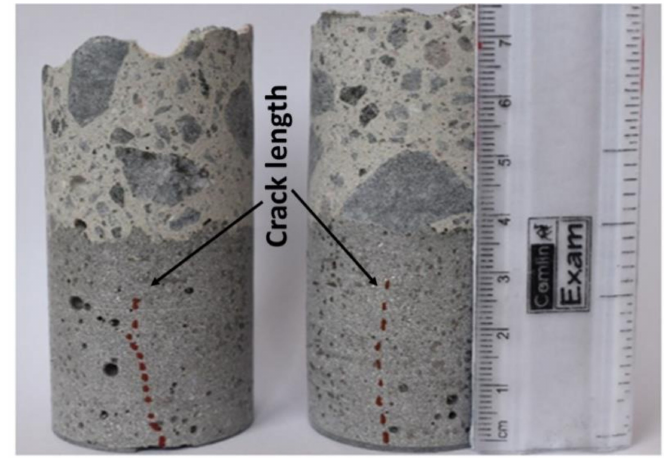
Figure 12. Shrinkage crack—depth measurement.